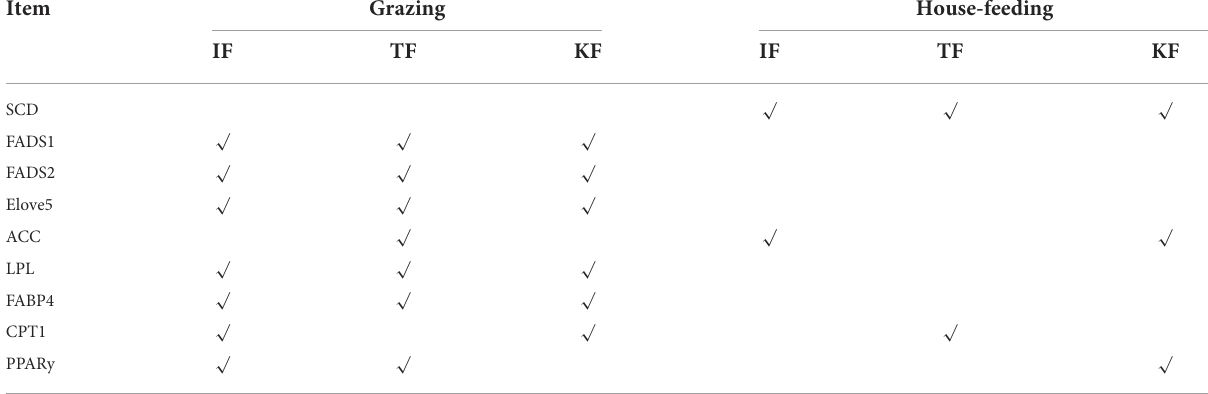
TABLE 4 Effects of feeding regimes on the expression of fat metabolism genes in Intramuscular fat (IF), Tail fat (TF), Kidney fat (KF) of Sunite sheep (58).